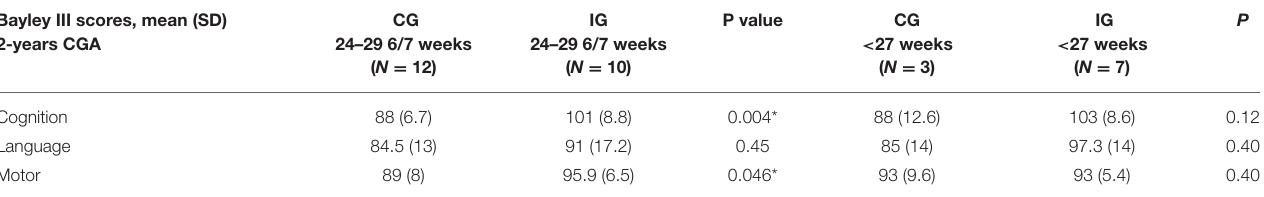
TABLE 4A | Neurodevelopmental outcome at 2-years corrected gestational age in control and interventional groups.